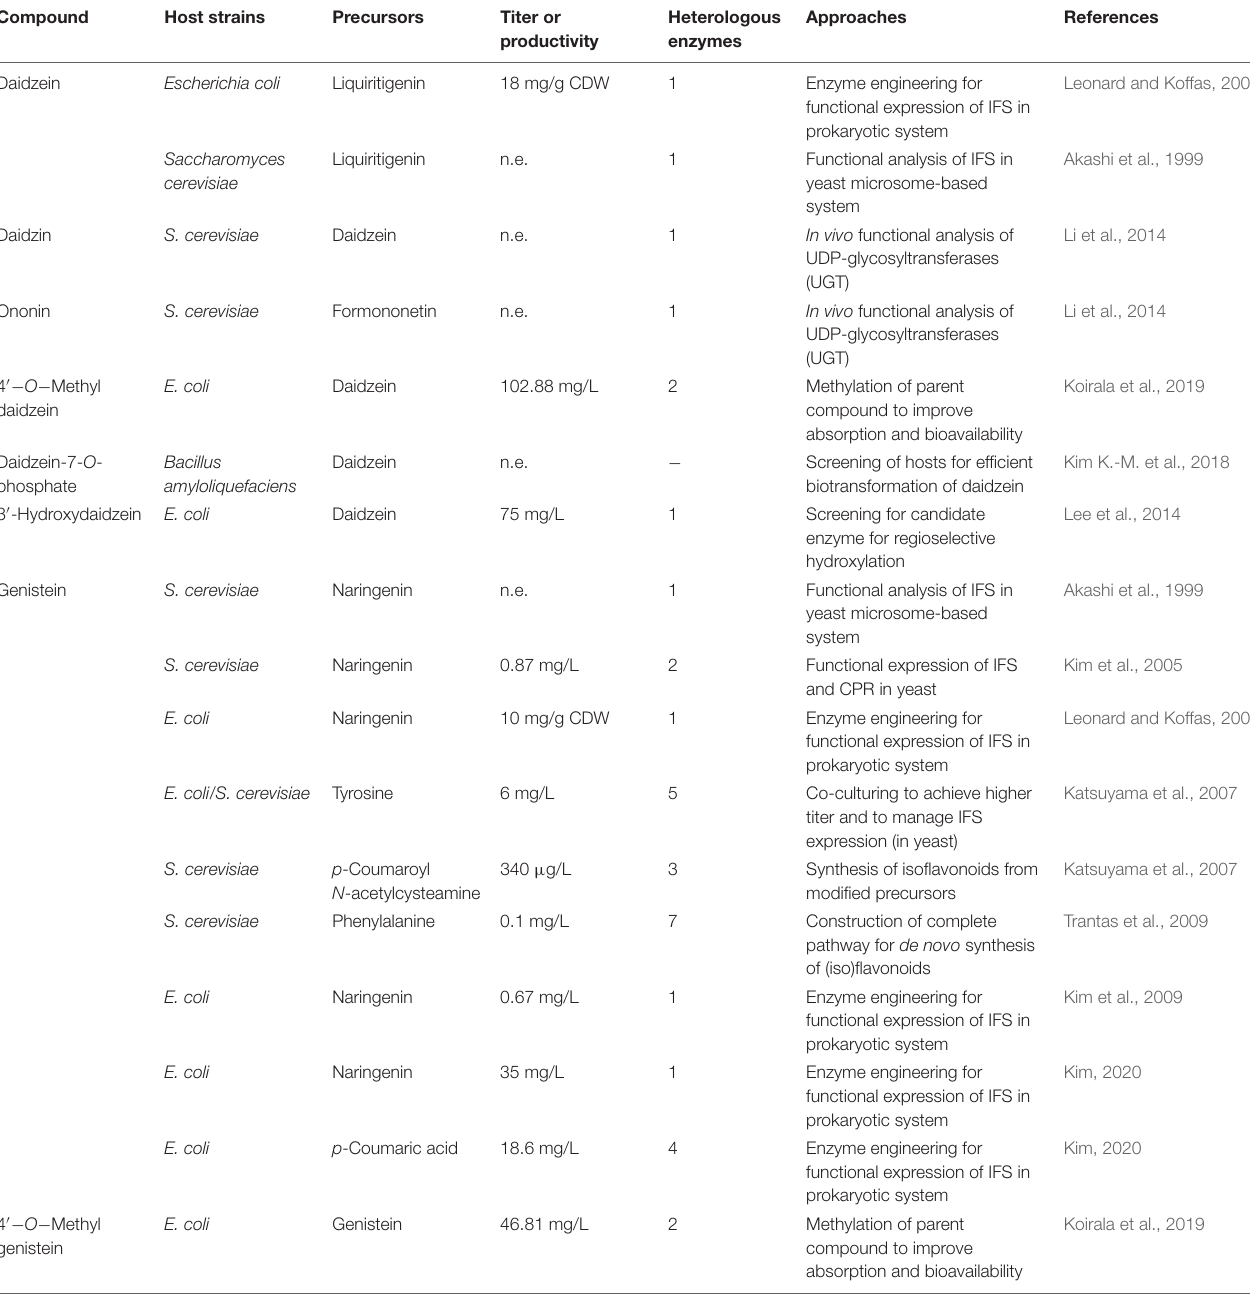
TABLE 2 | Isoflavonoid biosynthesis using heterologous hosts (microorganisms).